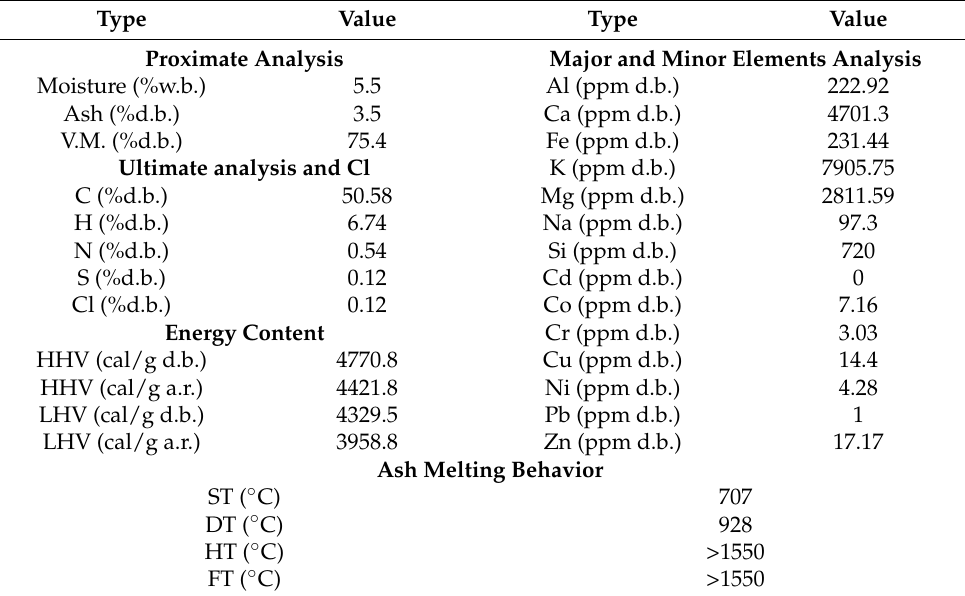
Table 10. Sunflower husk pellet